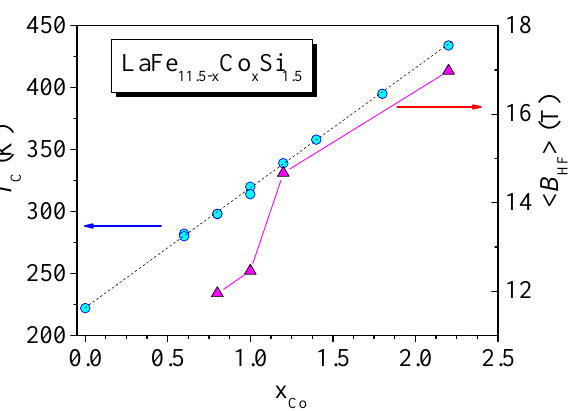
Figure 6. Evolution of the Curie temperature T C and the weighted average hyperfine field < B HF > versus x Co content [52].